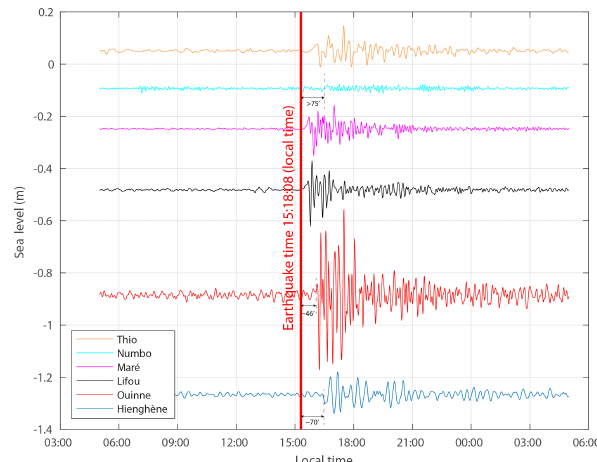
Figure 7. Sea-level variations recorded by tide and pressure gauges in New Caledonia following the 16 September 2015 earthquake that occurred in Illapel, Chile.